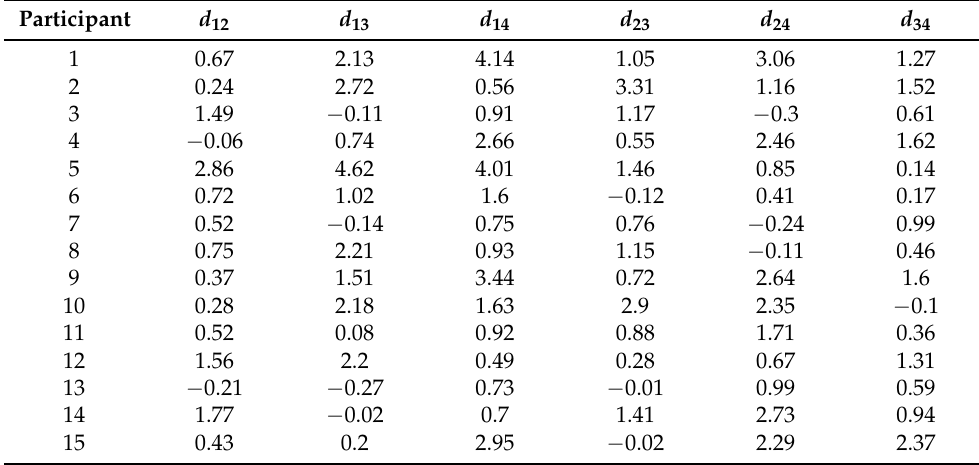
Table 2. Comparison of model parameter